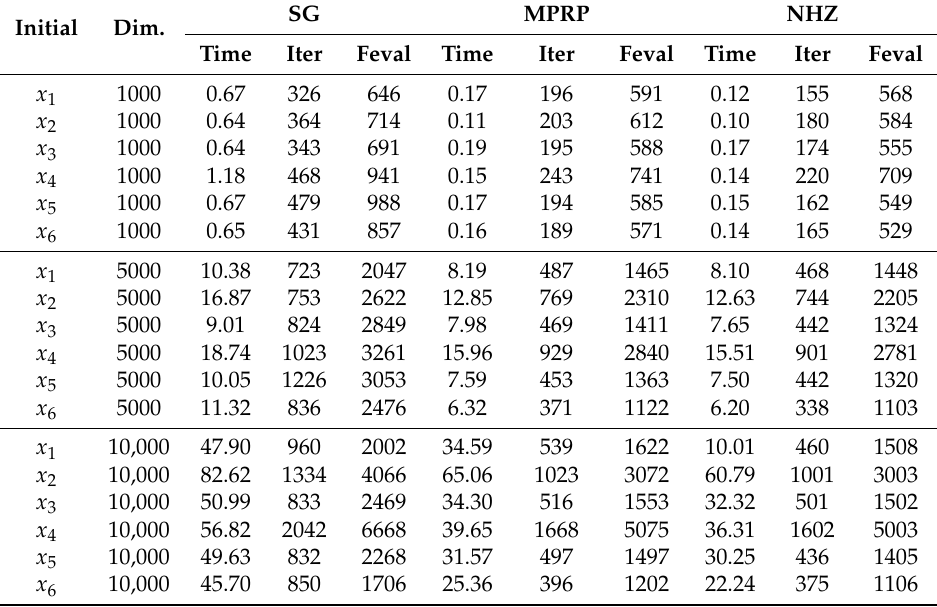
Table 2. Numerical results for the tested Problem 2 with various sizes and given initial points.